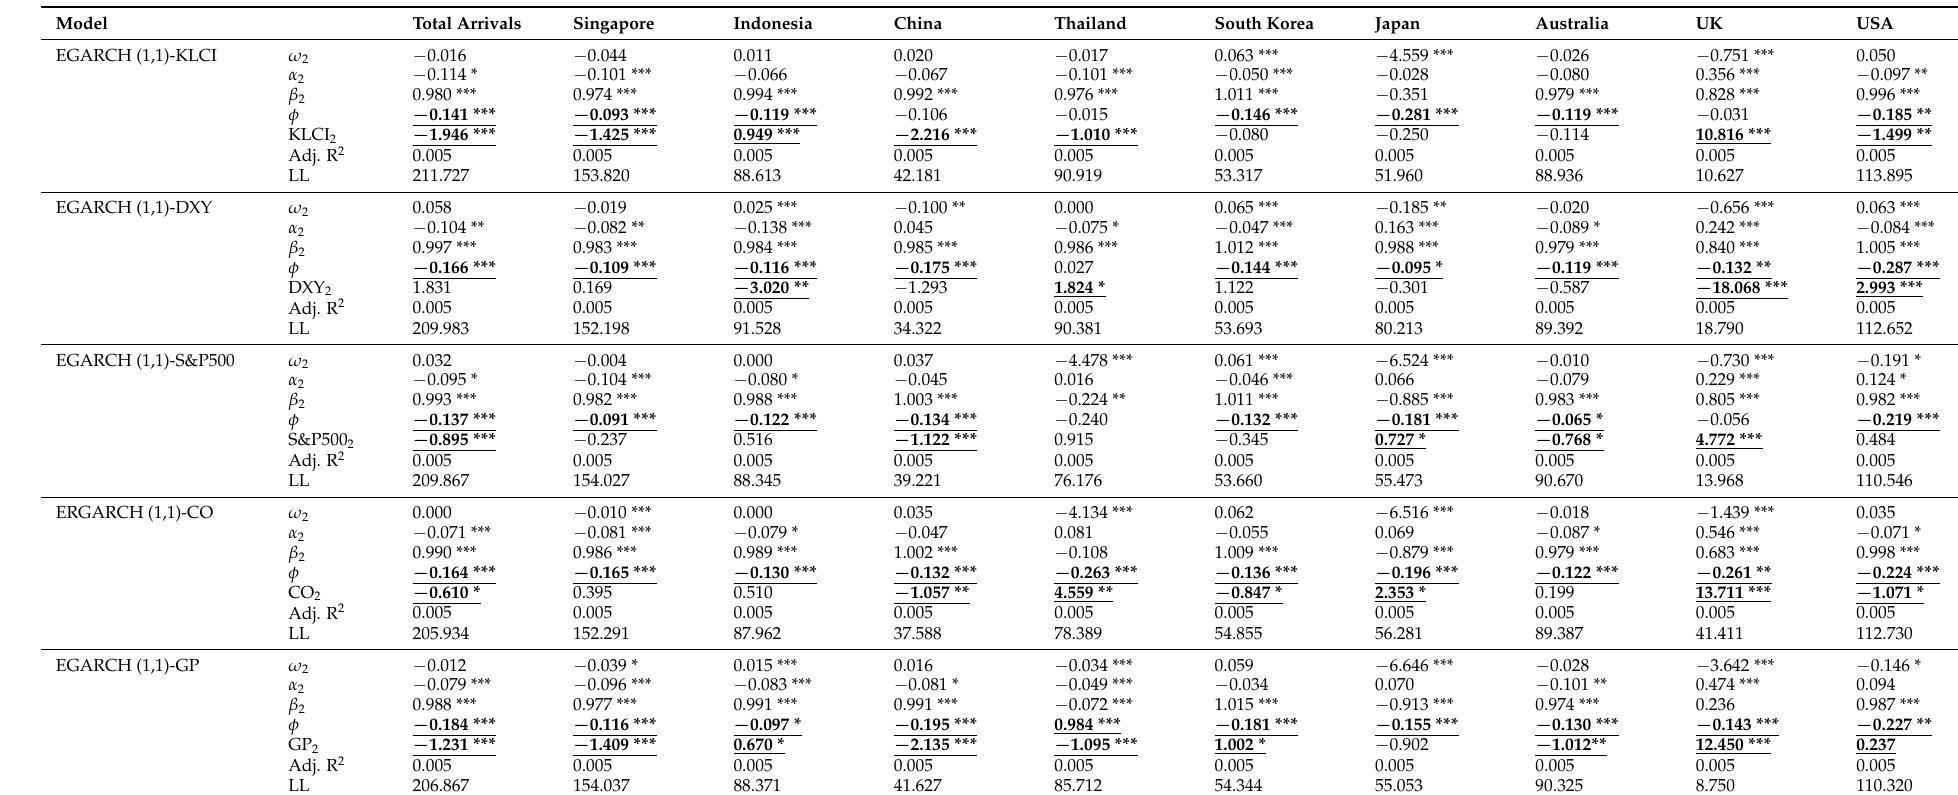
Table 8. Conditional variance equation for EGARCH model with financial news